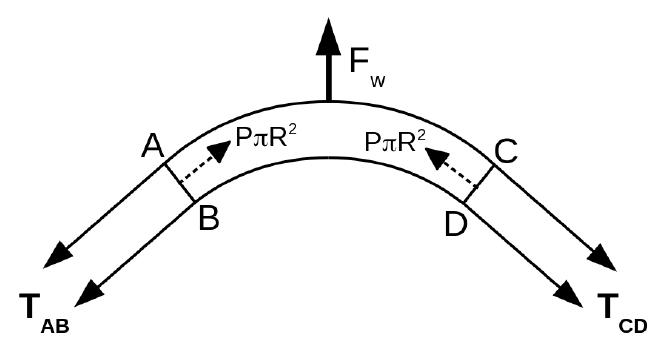
Figure A1. Forces applied to the curved tube element without flexural rigidity subject to internal pressure and axial